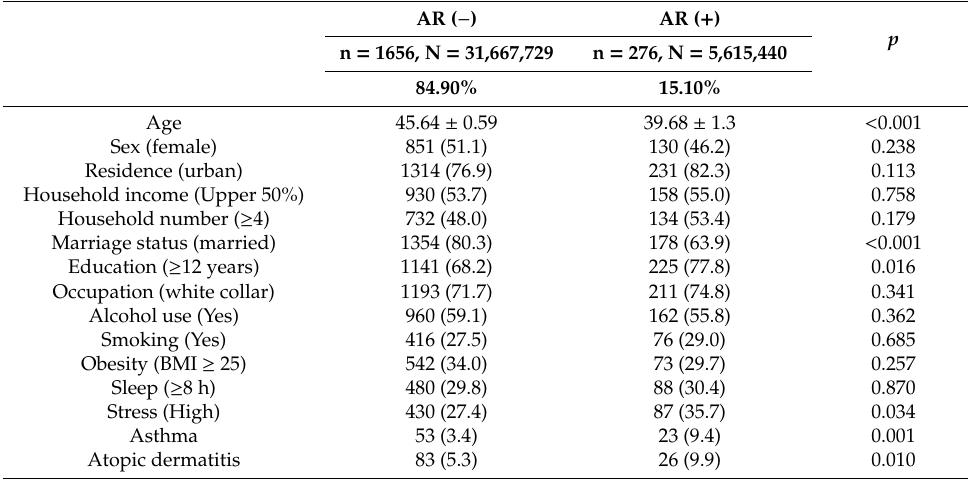
Table1. BaselinecharacteristicsofadultswithandwithoutallergicrhinitisaccordingtoKNHANES2010. AR ( −